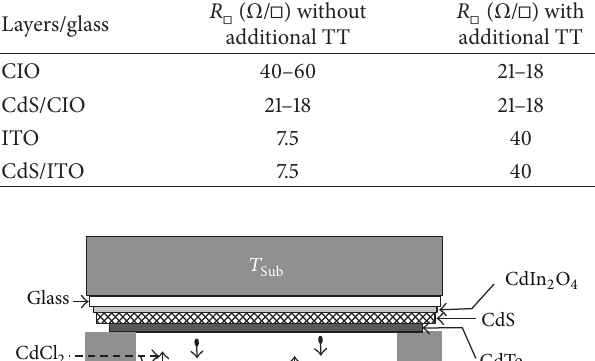
Table 2: Resistance per square ( 𝑅 ◻ ) data of the CIO, CdS/CIO, ITO, and CdS/ITO without and with an additional thermal treatment at 525 ∘ C during 15min in the CSS system.